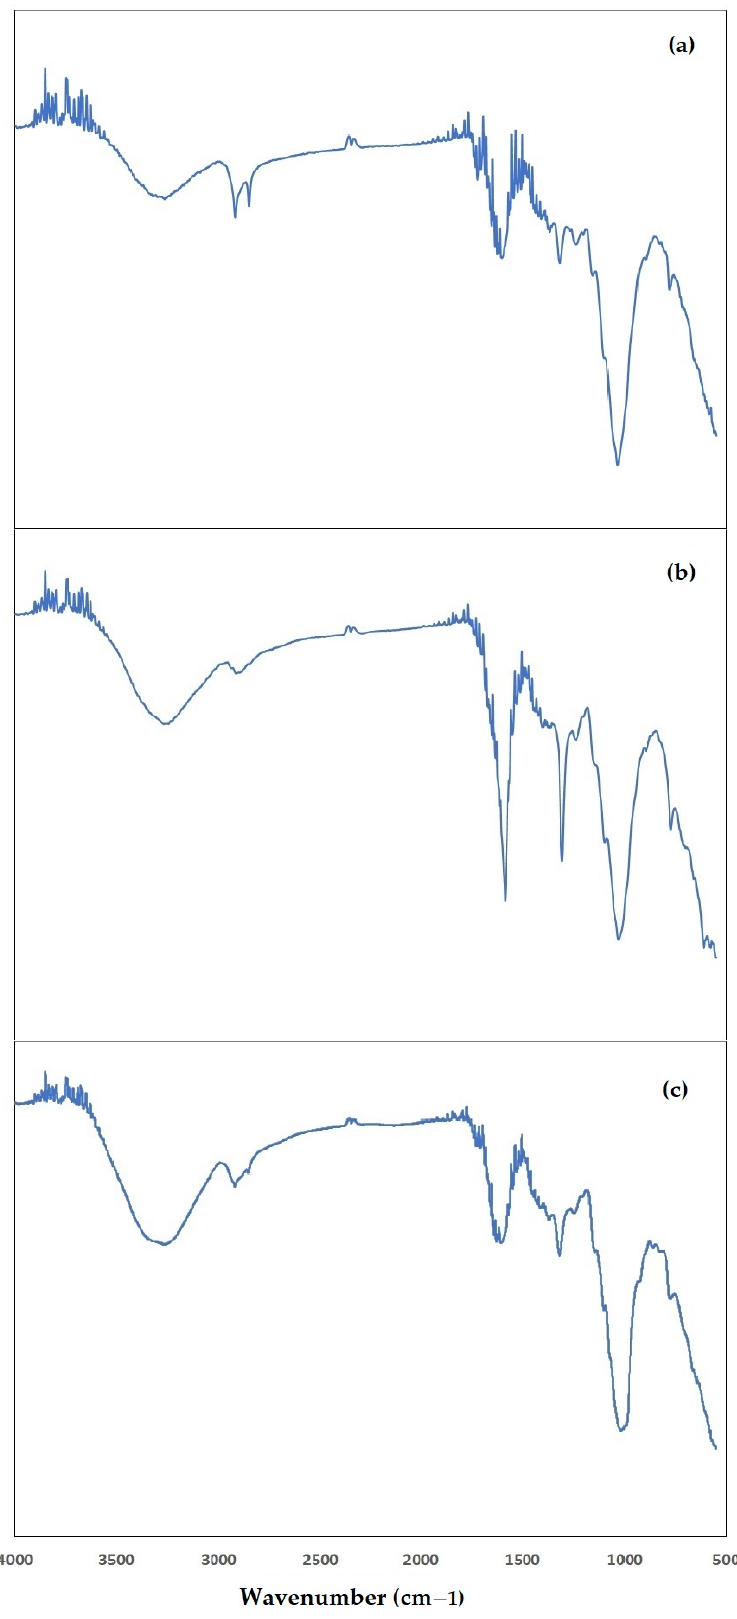
Figure 3. FTIR spectrum of biomass in ( a ) leaves, ( b ) rachis, and ( c )